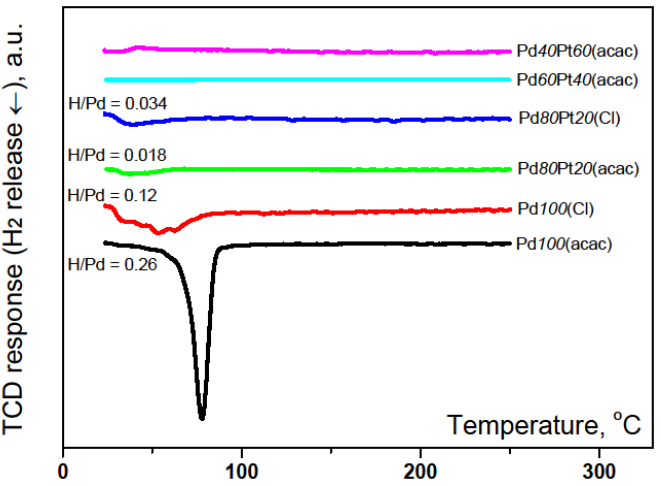
Figure 2. Temperature-programmed hydride decomposition profiles of Pd–Pt/C catalysts.